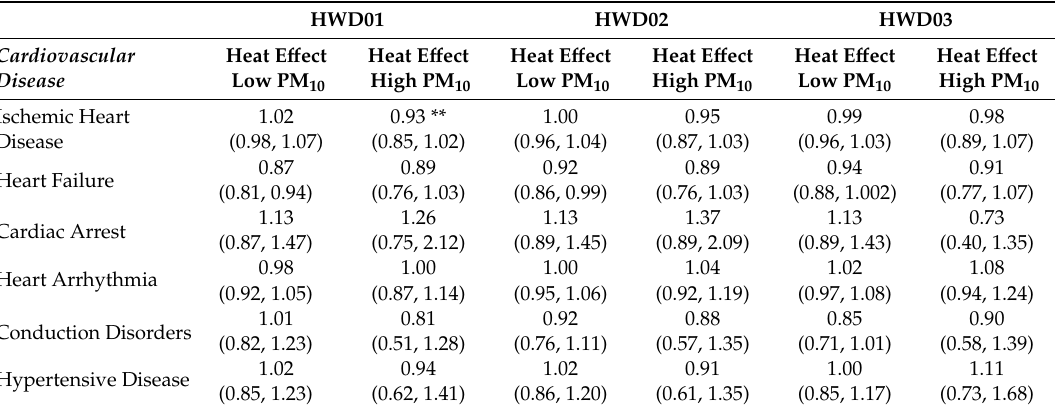
Table A1. The e ff ect of heat wave days on “emergency” hospital admissions (EHAs) for six cardiovascular diseases on days with high levels of particulate matter (PM 10 ) compared to days with low levels of PM 10 in the Sydney Statistical Division (SSD) during the warm season, 2001 to 2013, for all ages at lag 2